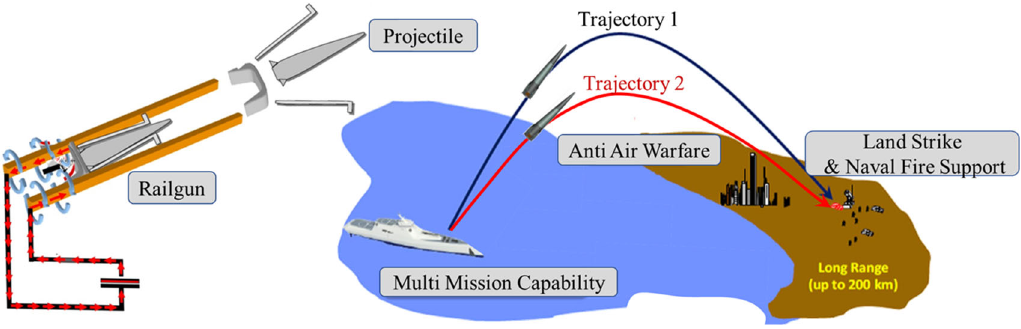
Figure 1. Hypersonic projectile fired by an electromagnetic railgun.